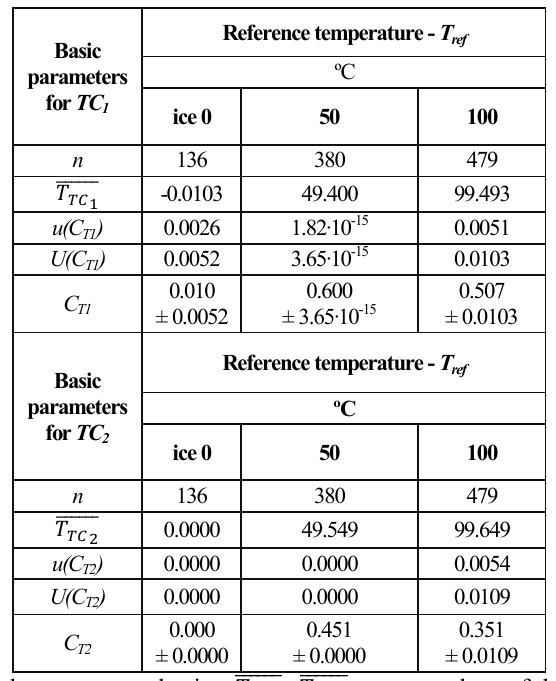
Table 1. Selected corrections for temperature measurement for tested thermocouples.